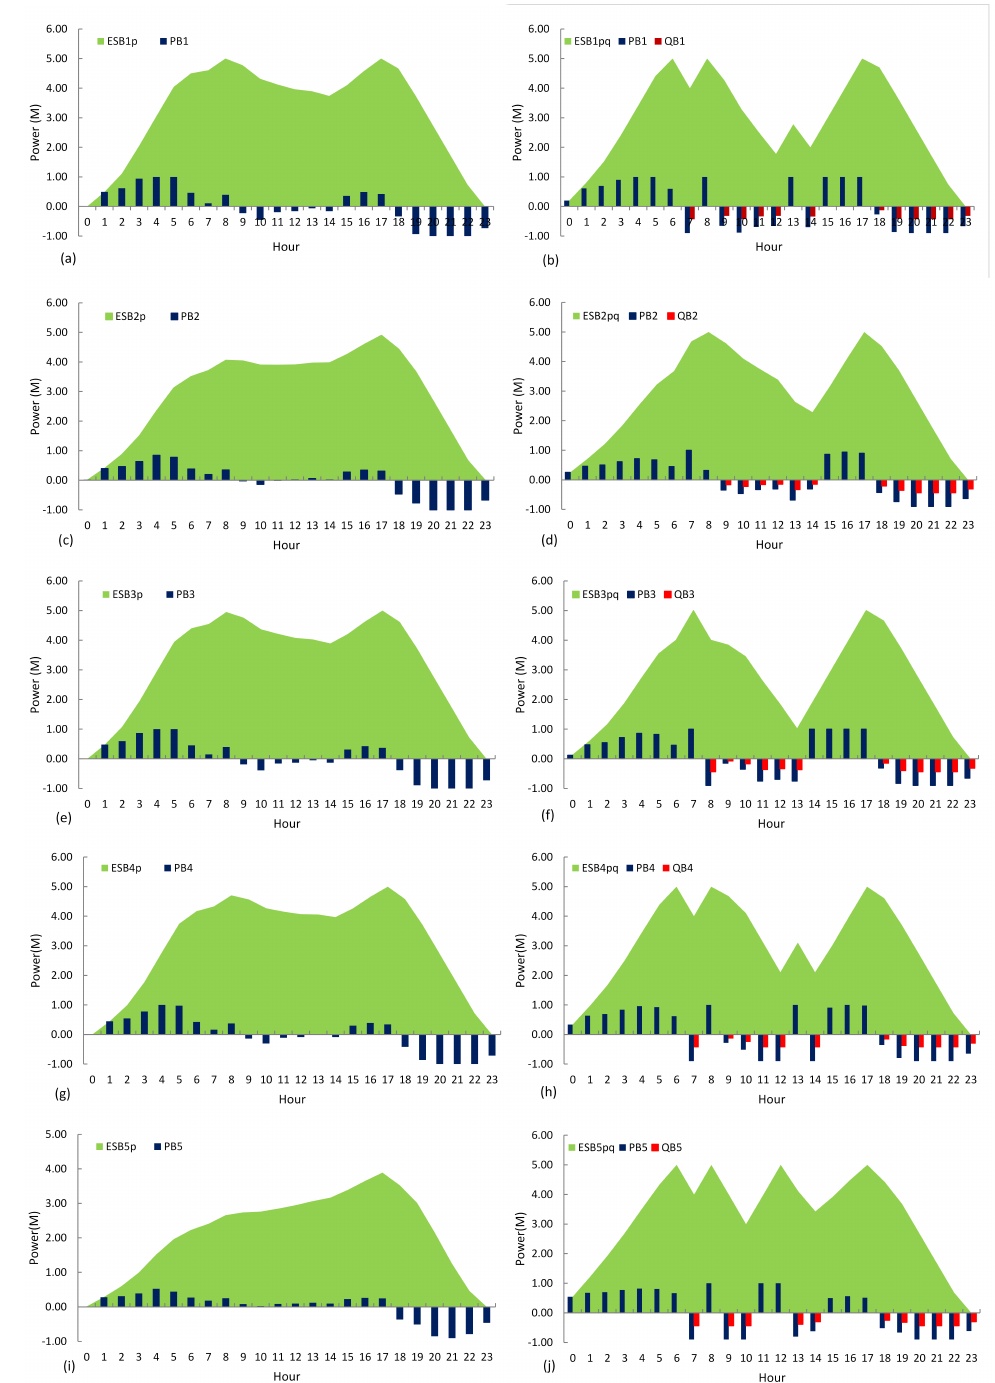
Figure 15. Power management for five BESS units: ( a ) active power BESS 1; ( b ) active and reactive power BESS 1; ( c ) active power BESS 2; ( d ) active and reactive power BESS 2; ( e ) active power BESS 3; ( f ) active and reactive power BESS 3, ( g ) active power BESS 4; ( h ) active and reactive power BESS 4; ( i ) active power BESS 5; ( j ) active and reactive power BESS